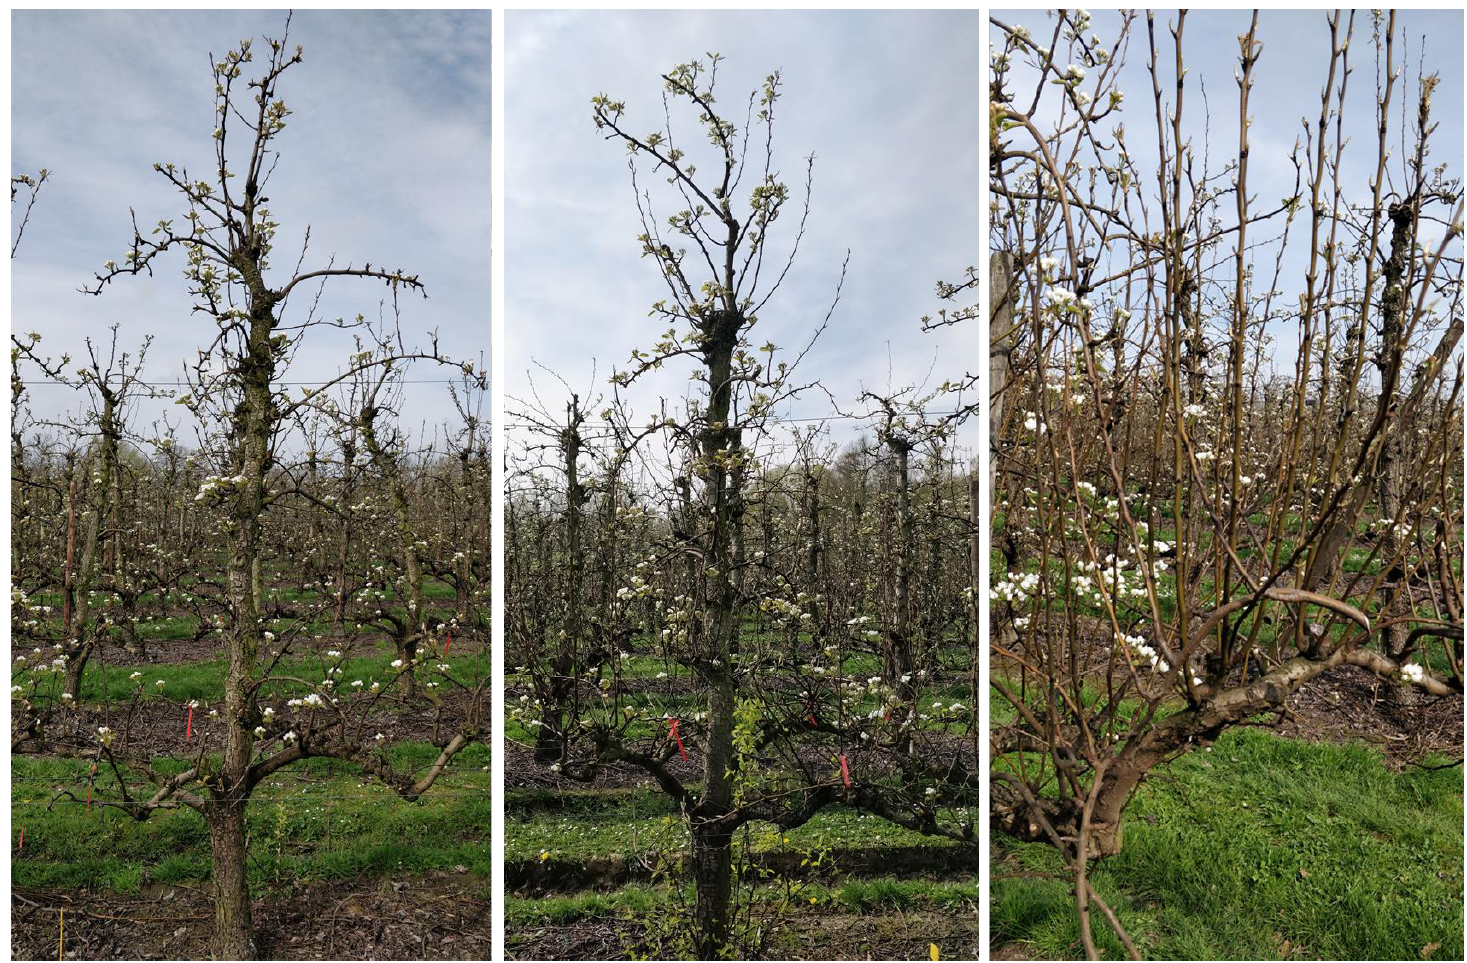
Figure A5. A pruned tree (left, plot 5C) and an unpruned tree (middle, plot 1C) in the Wimmertingen orchard with a close-up of the unpruned branches (right). 229